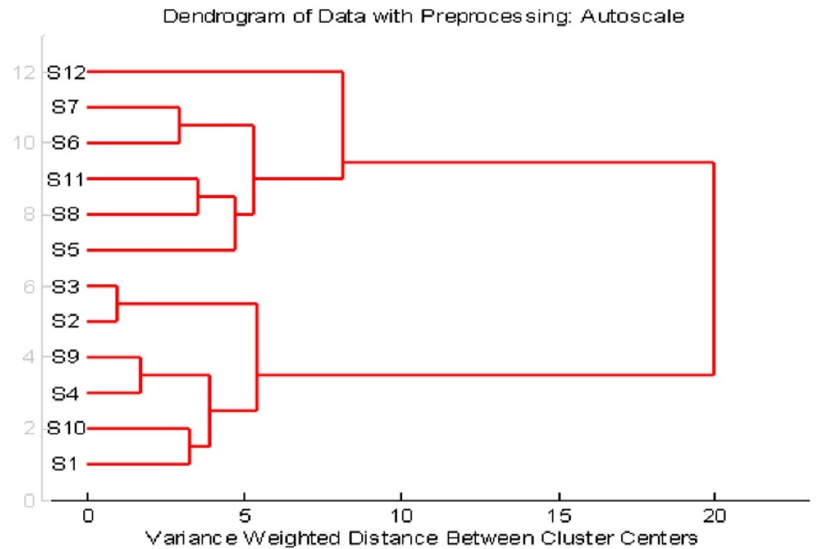
Figure 4. Dendrogram of chocolate samples with different cocoa content.